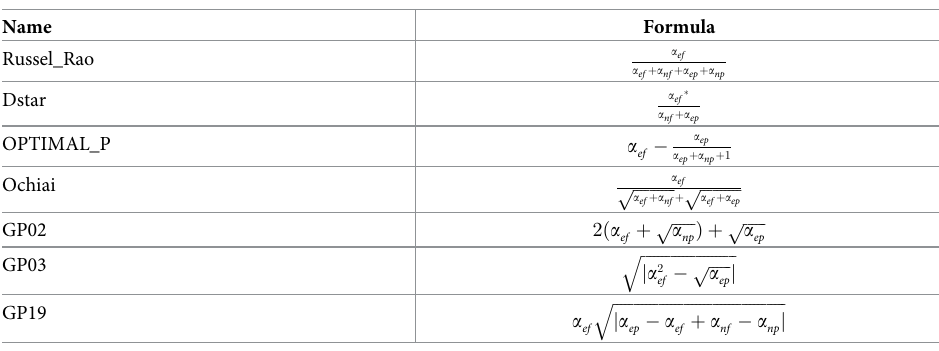
Table 1. Definitions of evaluation metrics used.